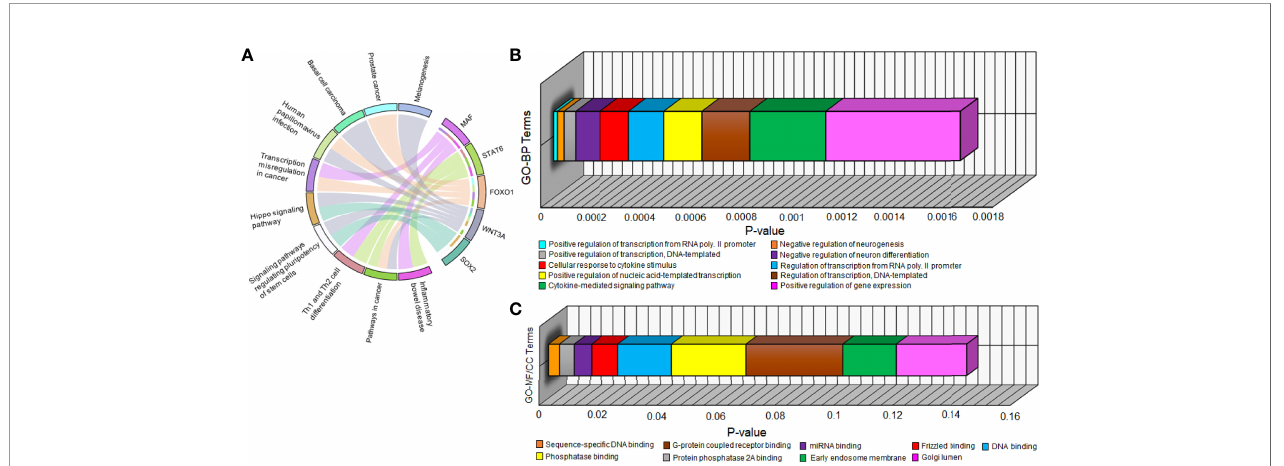
FIGURE 5 | (A) Chord plot showing the relation of 5 hub DEGs (on right semicircle track) with 10 signi fi cant pathways (on left semicircle track) via colored edges. The edges initiate from unique colored strips present on the right semicircle (indicating genes) and converge to unique colored strips present on the left semicircle (indicating pathways). Three-dimensional horizontal bar plots show top 10 signi fi cant (B) GO-BP and (C) GO-MF/CC terms on the y-axis regarding p-values on the x-axis. Every unique colored block signi fi es a different GO term.